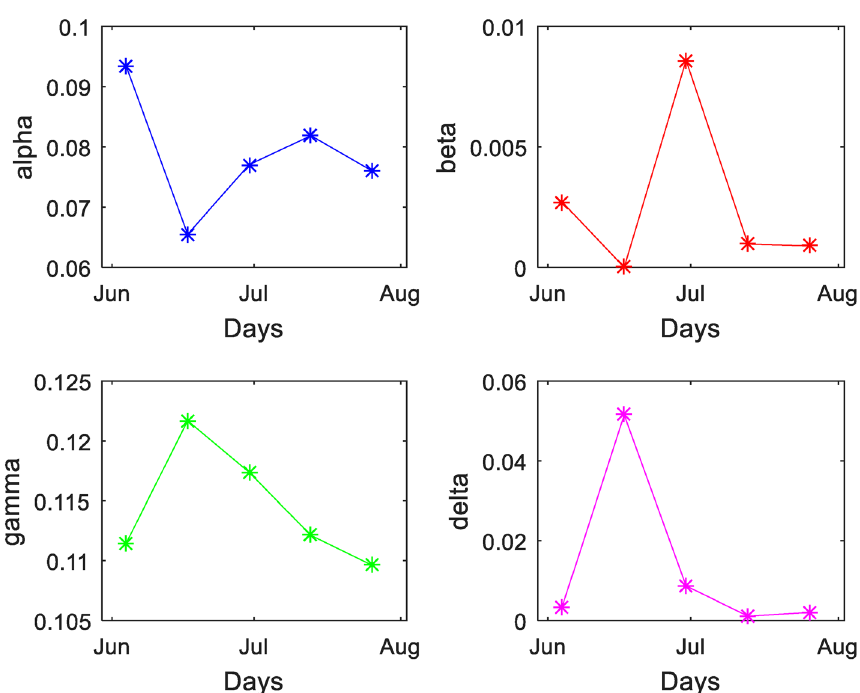
Figure 5. The transmission parameters versus